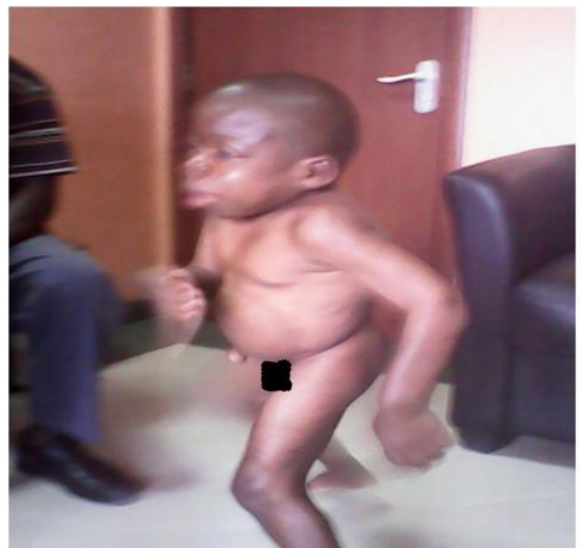
Figure 1: Shows some of the clinical findings such as thick lips, umbilical hernia, and bony deformities such as chest deformity, large dolicocephalic head with frontal bossing. Elbow, wrist and knee joints are held in flexion due to